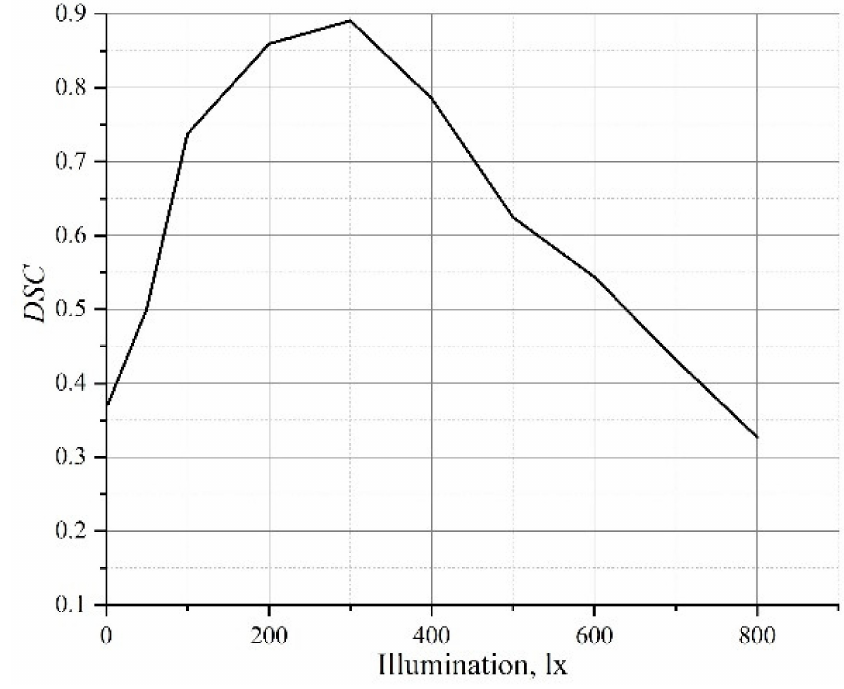
Figure 10. Dependence of the DSC coefficient on lighting. Table 1. Summary of quantitative indicators of defect recognition in